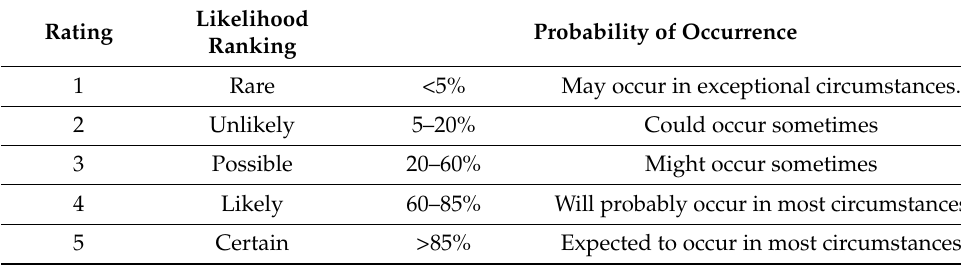
Table 3. Suggested ratings of likelihood and ranking of probability of failure, P f [56].